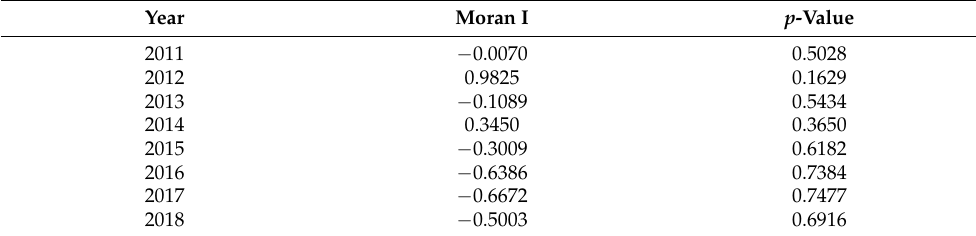
Table 7. Standardised values of Moran’s index for spatial panel model